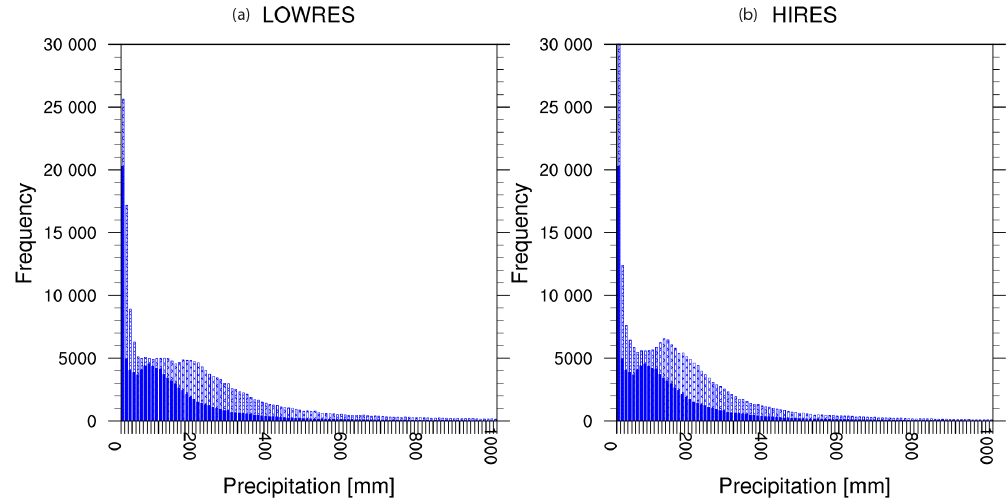
Figure 16. Histogram of the 2-month accumulated precipitation by using the CMORPH data over land points only. The filled blue bars denote the CMORPH data set and the cross-hatched bars denote the LOWRES (a) and HIRES simulation data (b) .